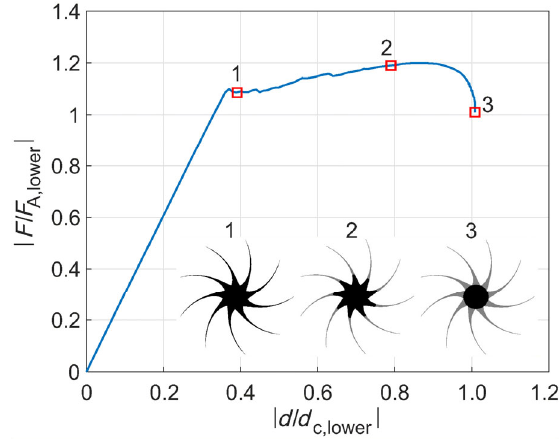
Fig. 9 Detachment process of a flat-ended indenter with the cross- section in form of a “star” having “rays” which satisfy Eq. (29). In this case, a constant pulling force is predicted in the whole range where this dependence is